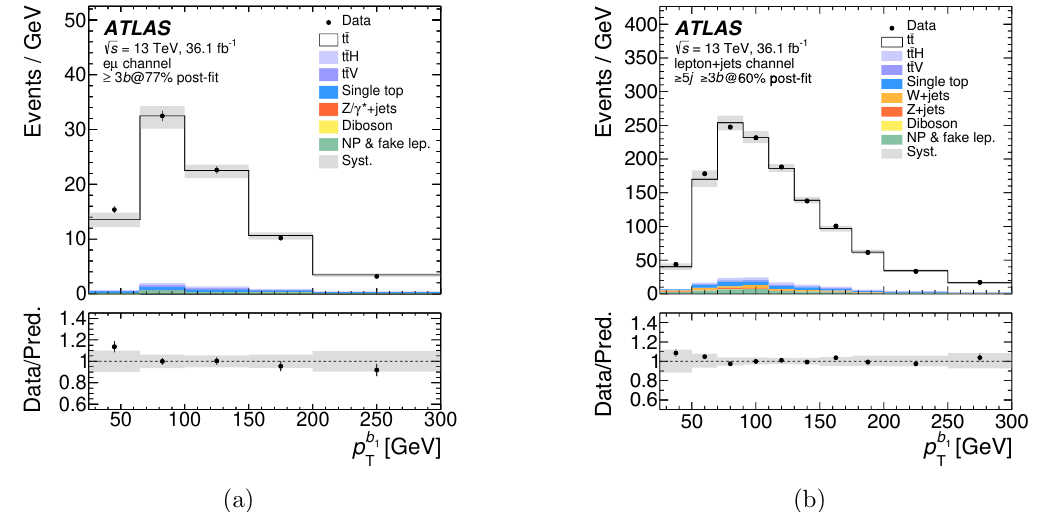
Figure 6. Comparison of the data distributions with predictions for the leading b -tagged jet p T , after applying scale factors, in events with at least 3 b -tagged jets, in the (a) e(cid:22) and (b) lepton + jets channels. The systematic uncertainty band, shown in grey, includes all uncertainties from experimental sources. Events that fall outside of the range of the x -axis are not included in the plot.